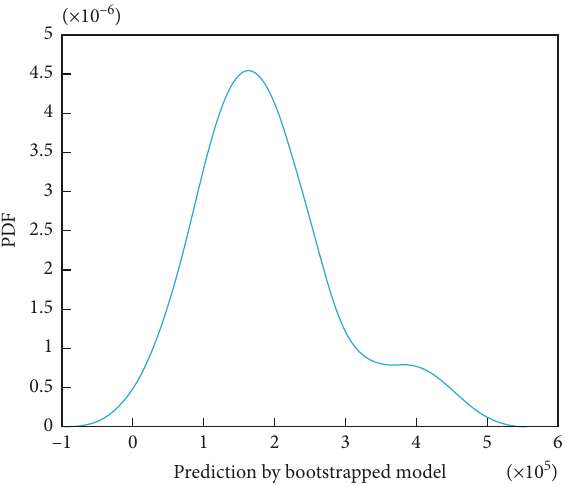
Figure 15: PDF curve of the model